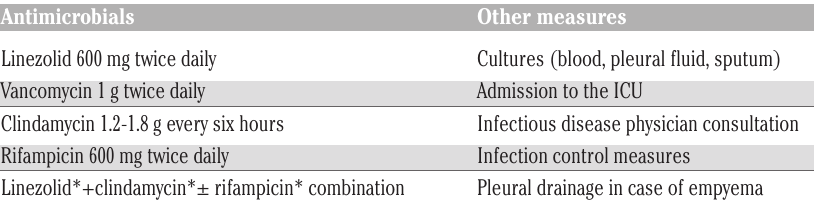
Table 3. Therapeutic principles for